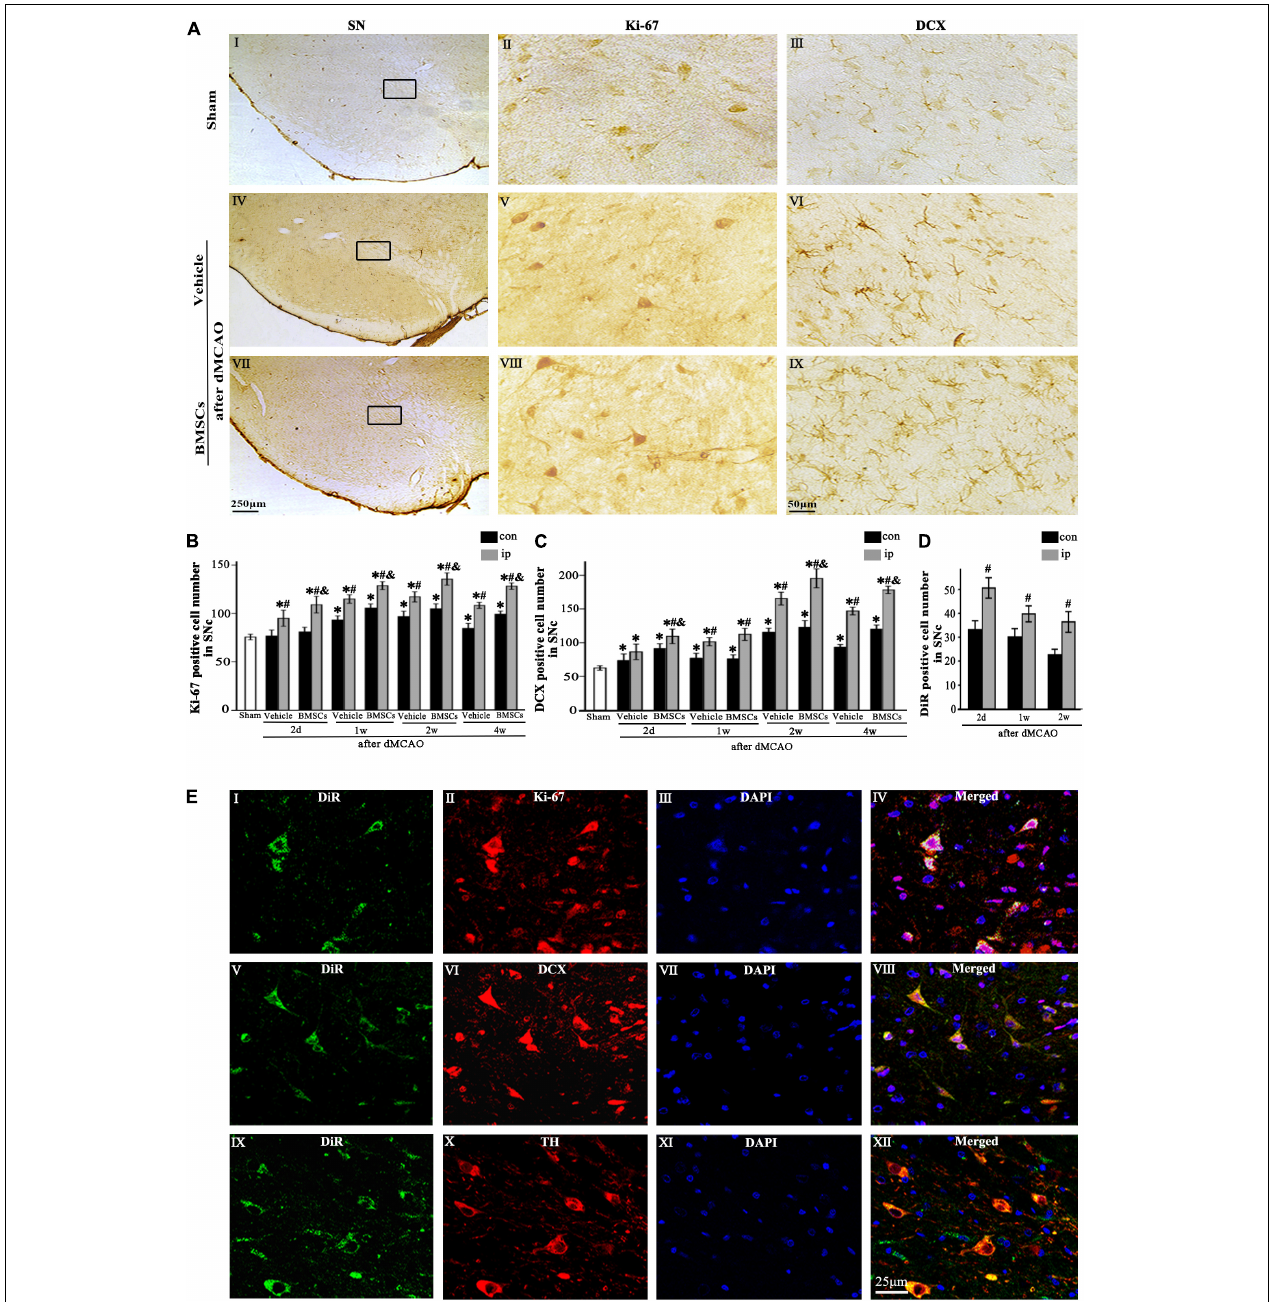
FIGURE 3 | The proliferation and differentiation of BMSCs in SNc after dMCAO. (A) Representative microphotographs of immunohistochemistry for Ki-67 and DCX in SN after dMCAO with or without BMSCs transplantation. (I–III) Sham group; (IV–VI) vehicle group at 2 days after dMCAO; (VII–IX) BMSCs group at 2 days after dMCAO; (B,C) Quantitative analyses of Ki-67 + and DCX + cells in SNc at 2 days, 1, 2, and 4 weeks after dMCAO. BMSCs transplantation increased the numbers of Ki-67 + cell [ F ( 4 , 106 ) = 90.12, p < 0.01] and DCX + cell [ F ( 4 , 106 ) = 154.17, p < 0.01] in the ipsilateral SNc after dMCAO). (D) Quantitative analyses of DiR + cells in SNc at 2 days, 1 and 2 weeks after dMCAO. The number of ipsilateral BMSCs-DiR + cells was significantly increased after dMCAO [ F ( 2 , 57 ) = 13.93, p < 0.01]. (E) Representative images of fluorescent staining of BMSCs-DiR + ( I,V,IX, green) and Ki-67 ( II , red), DCX ( VI , red), TH ( X , red) and DAPI ( III,VII,XI , blue) in SNc with BMSCs transplantation at 1 week after dMCAO. The overlapped images showed that DiR + BMSCs were colocalized with Ki-67 + , DCX + , and TH + cells, respectively at 1 week after dMCAO (IV,VIII,XII) . Scale bar: A, I, IV, VII, 250 µ m; II, III, V, VI, VIII, IX , 50 µ m; (E) , 25 µ m. Data are represented with mean ± S.D. ∗ p < 0.05 vs. sham-operated group, # p < 0.05 vs. contralateral groups at the same time point and & p < 0.05 vs. ipsilateral vehicle groups ( n = 6 in each group). SN, substantia nigra; SNc, substantia nigra compact part; DCX, doublecortin; Sham, sham-operated; BMSCs, bone marrow stromal cells; con, contralateral; ip, ipsilateral; d, day; w, week; dMCAO, distal middle cerebral artery occlusion, DiR (1,1-dioctadecyltetramethyl indotricarbocyanine iodide), Ki-67, nuclear-associated antigen Ki-67; DAPI, 4’,6- diamidino-2-phenylindole; TH, tyrosine hydroxylase.